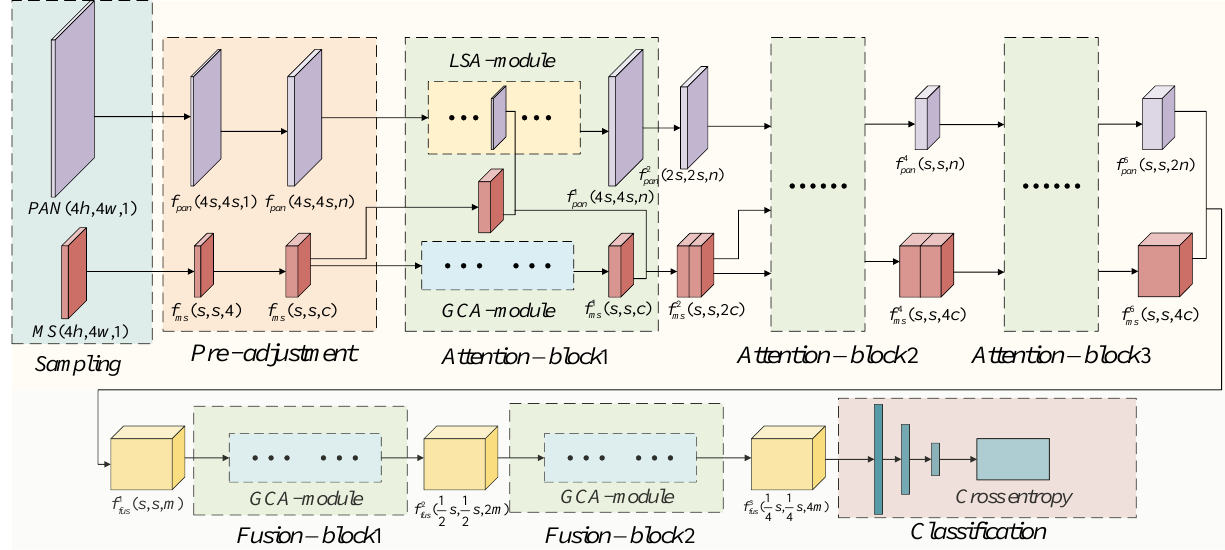
Figure 5. The proposed a spatial-channel attention enhancement network (SCCA-Net) for multiresolution classification. The network is divided into four parts: the first is to pre-adjust the feature map; the second is to stack attention blocks for feature extraction; then the feature fusion is performed; and finally the three fully-connection layers is used for